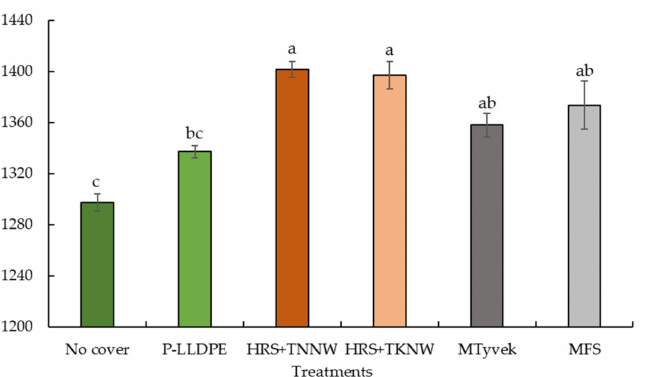
Figure 8. Accumulated time-temperature (ATT) ( ◦ C h) among the six treatments after simulated storage at 18 ◦ C for 48 h and simulated transportation at 30 ◦ C for 15 h. Different letters indicate significant differences at p < 0.05. Values are mean ± S.E. from four